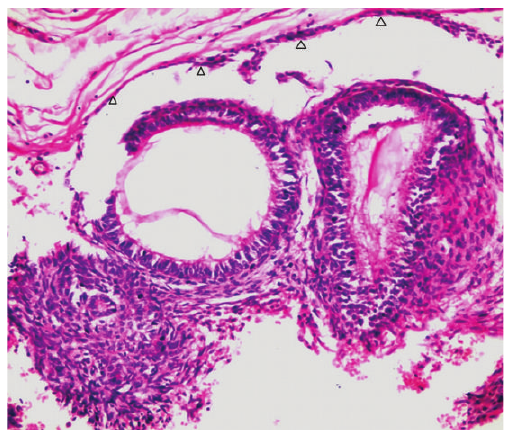
Figure 4: Duct-like structures of odontogenic epithelium; one filled with eosinophilic material, along with 1-2 cell layer think of cuboidal cells (arrows) (H&E × 40).